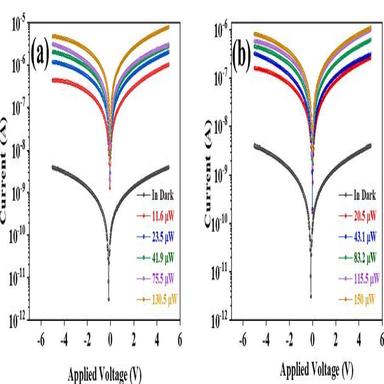
I-V characteristics of the Au/WBR/Au photodetector in dark and under (a) 375 nm, and (b) 405 nm laser illumination.